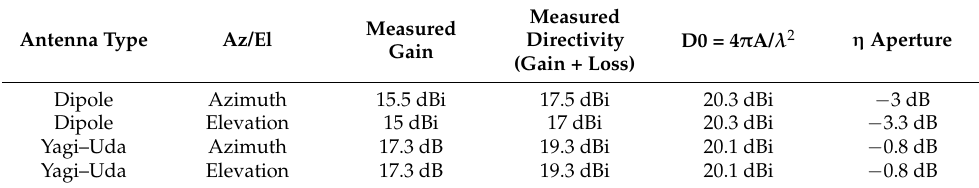
Table 6. Array efficiencies.